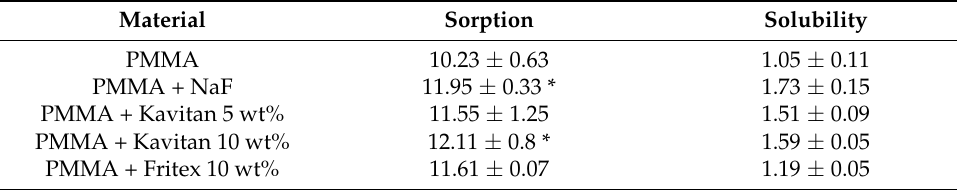
Table 5. Mean values ± SD of sorption and solubility after 7 days ( µ m/mm 3 nd–nondetectable. Small letters in rows and big letters in columns denote statistically significant